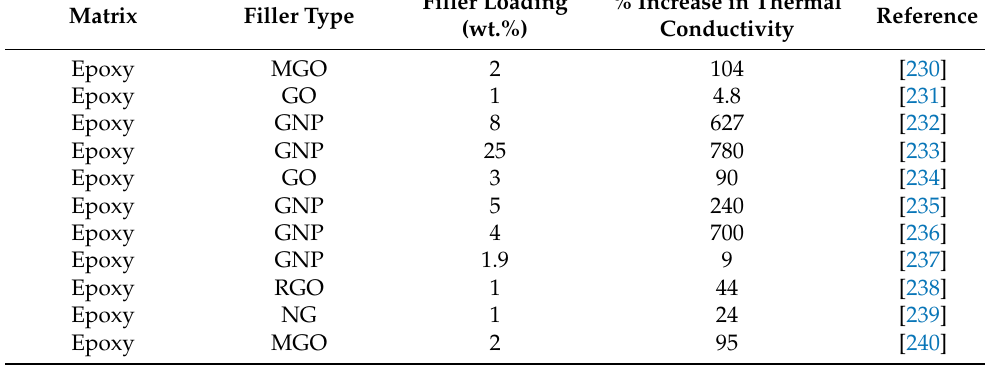
Table 2. Thermal conductivity values of graphene polymer nanocomposites. Matrix